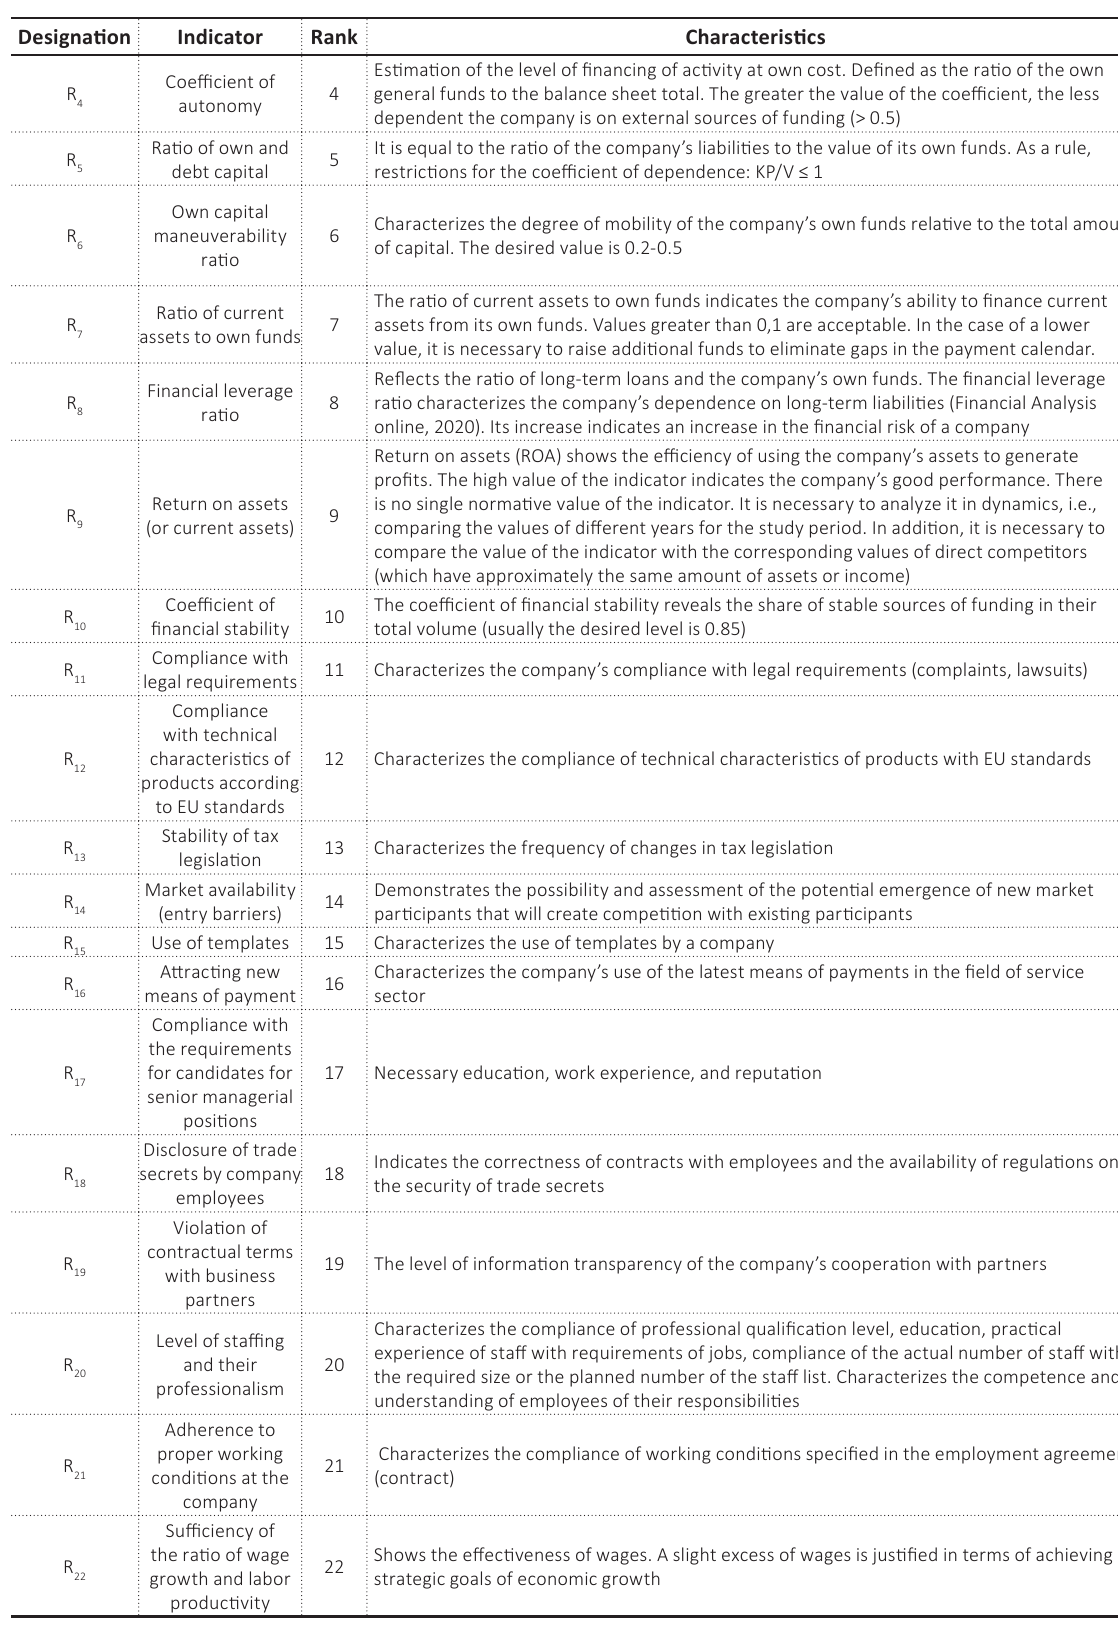
Table 2 (cont.). Indicators for assessing the stability of production and trading